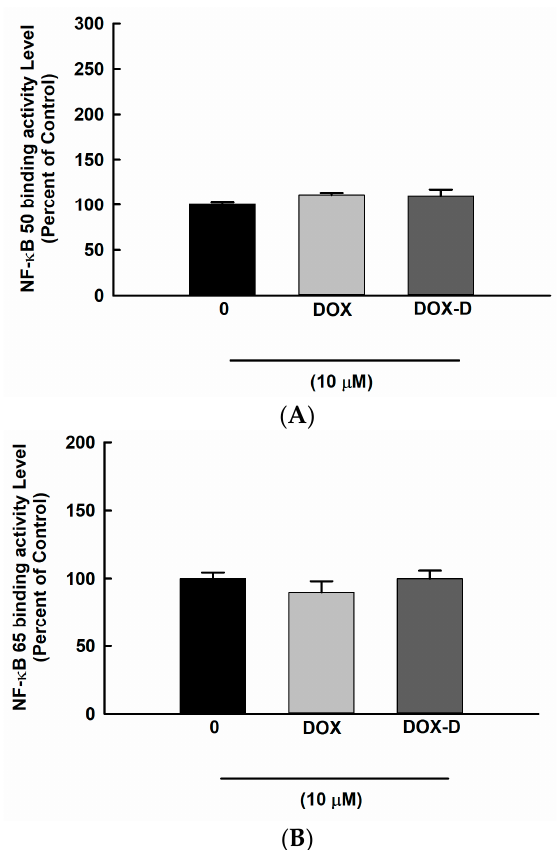
Figure 9. Effect of Effect of DOX and DOX-Vit D on NF- κ B signaling pathway. MG63 cells were treated for 24 h with 10 µM DOX and DOX-Vit D. Thereafter, NF- κ B binding activity was determined in nuclear